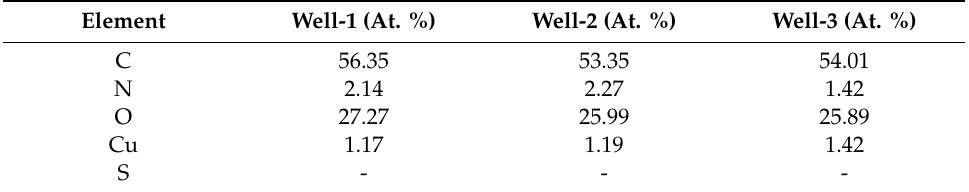
Table 4. Atom content (At. %) of CACu1 from the XPS wide scan spectra. Element Well-1 (At. %) Well-2 (At. %) Well-3 (At. %) C 56.35